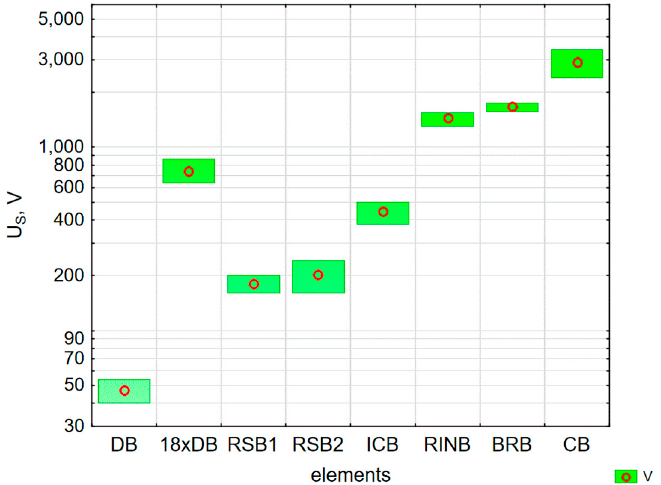
Figure 9. The results of the statistical analysis of damage of the integral parts of individual compo- nents of the type B lamp. nents of the type B